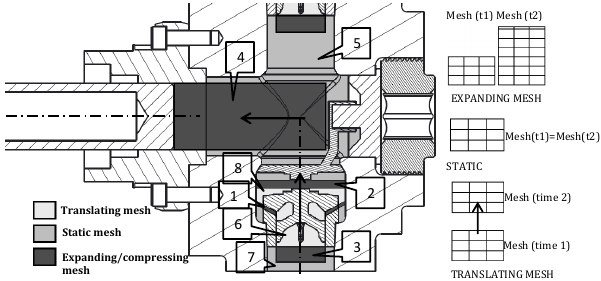
Figure 2. Decomposition pattern of the fluid volumes (Iannetti, Stickland, and Dempster 2014) . Figure 2: Decomposition pattern of the fluid volumes